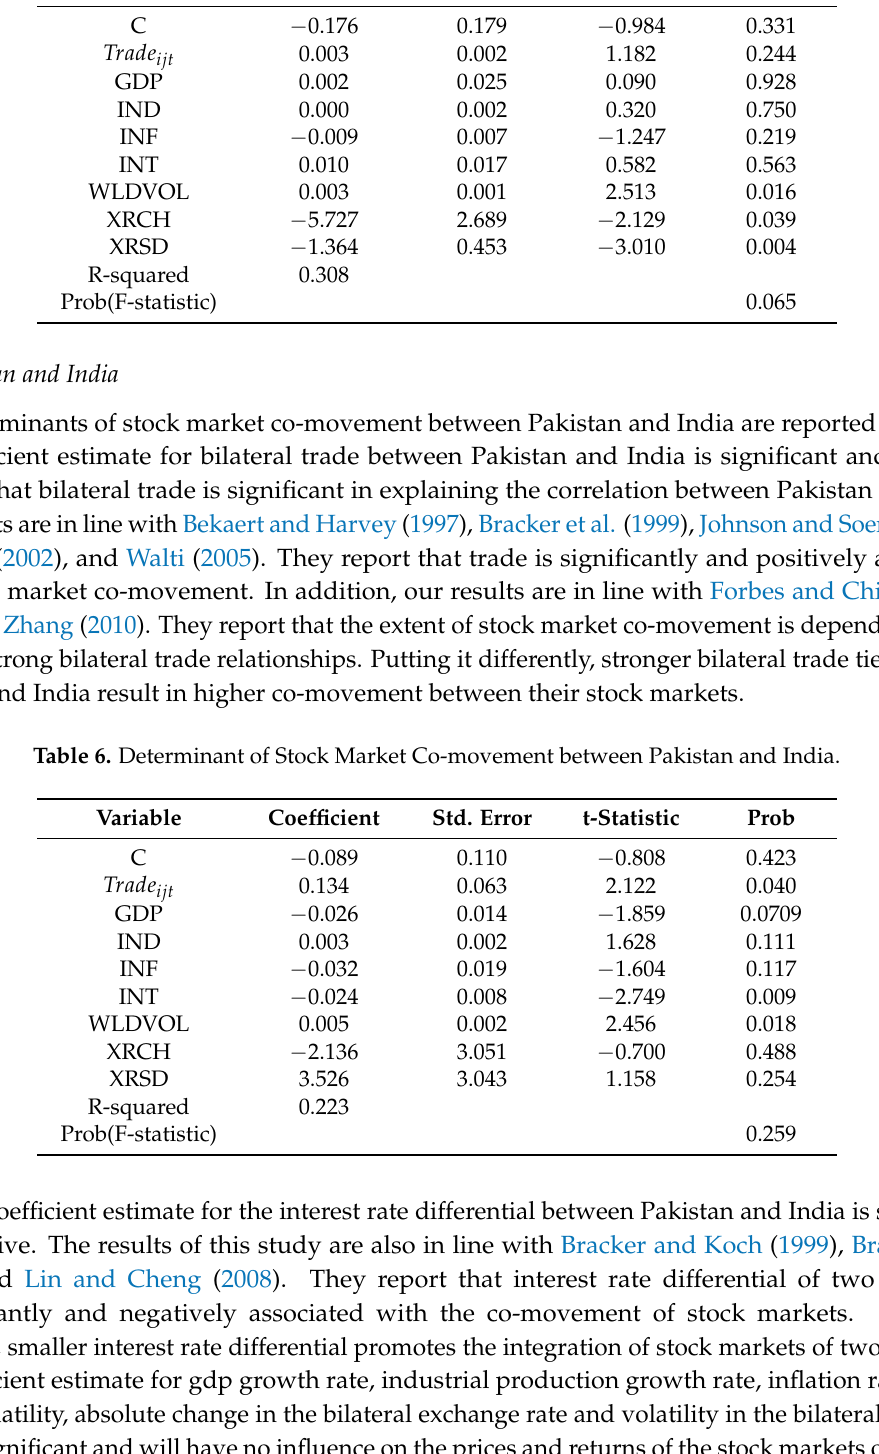
Table 5. Determinants of Stock Market Co-movement between Pakistan and China. Variable